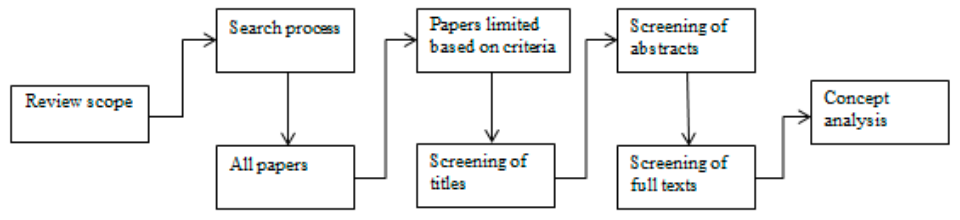
Figure 1. Article process selection.